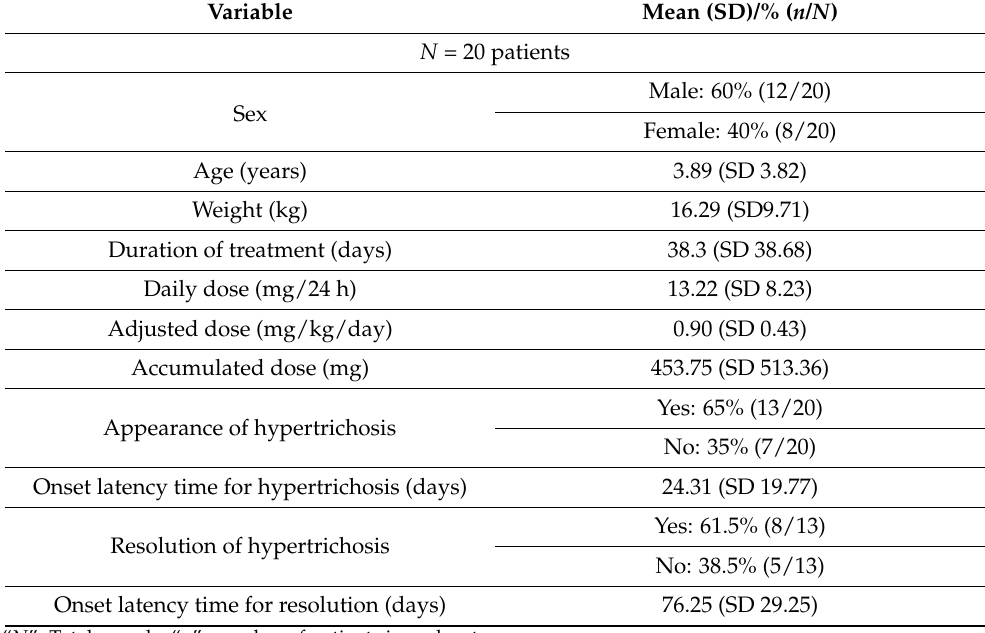
Table 1. Overview of the characteristics of the